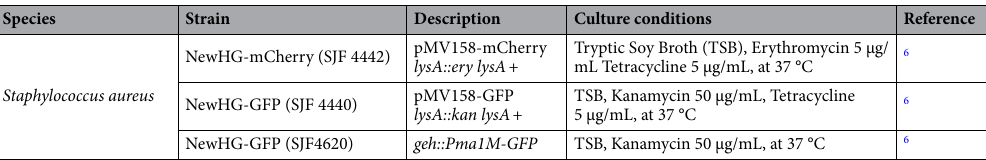
Table 1. Bacterial strains used in this